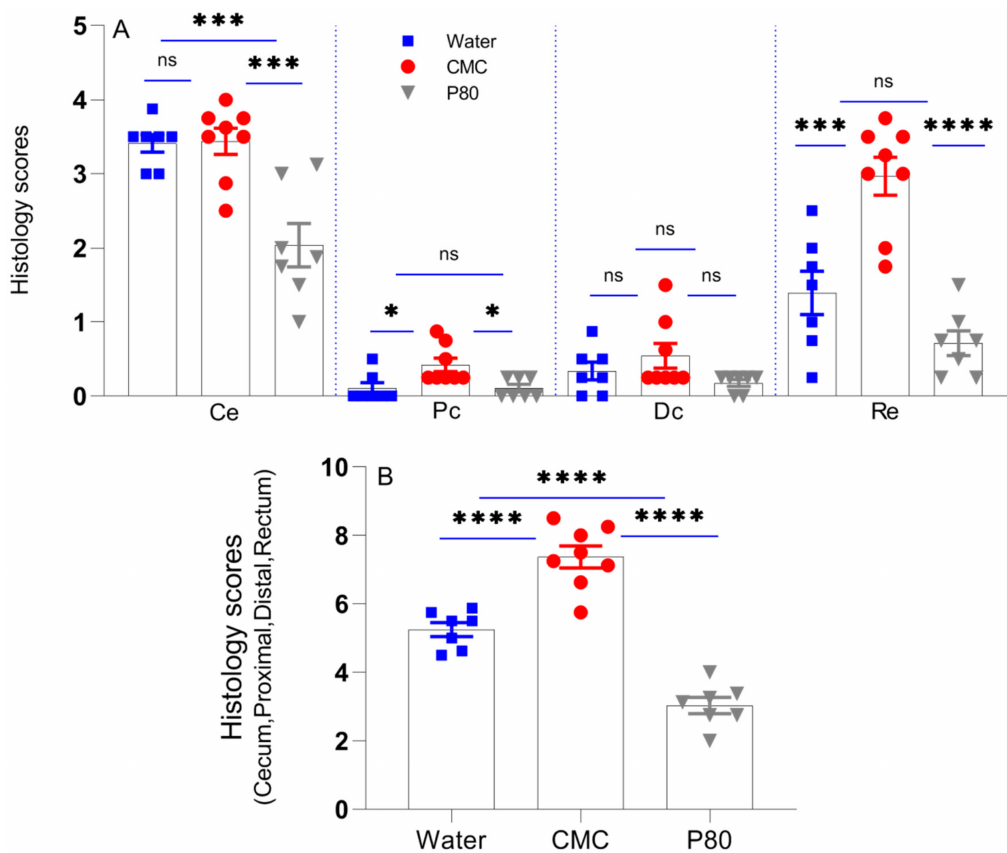
Figure 3. Blinded histological scores of the different sections of the colon ( A ) and overall scores ( B ) of humanized IL10 − / − mice exposed to CMC (1% w / v , red circle), P80 (1% v / v , gray triangle), and water (control, blue square). * p < 0.05; *** p < 0.001 and **** p < 0.0001 by one-way ANOVA followed by Tukey multiple comparisons